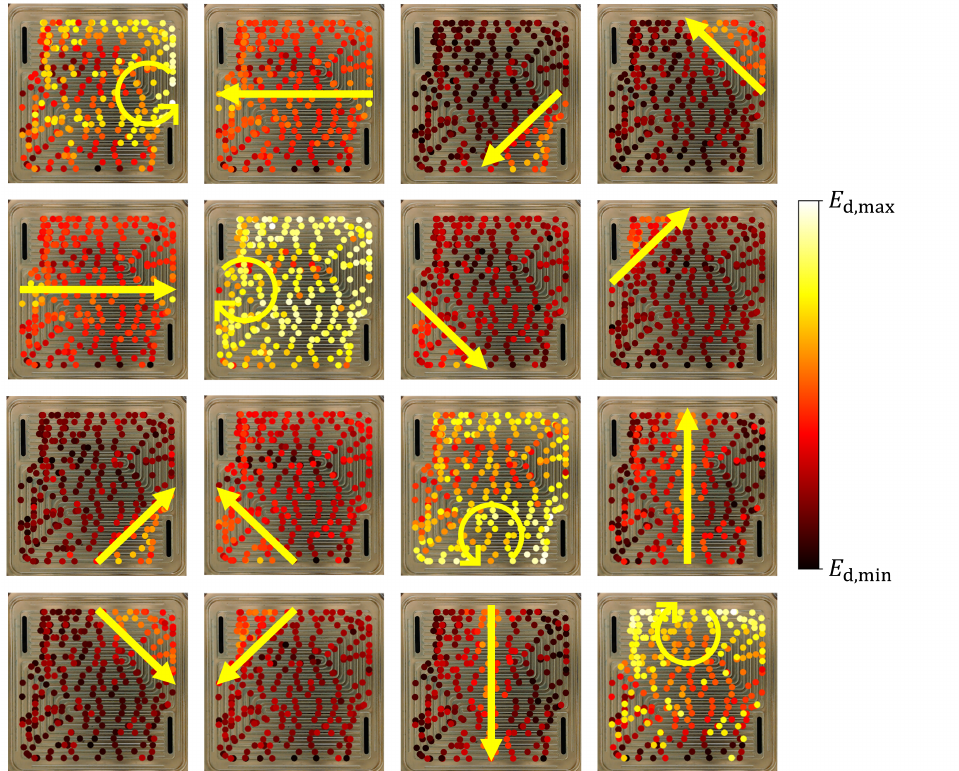
Figure 6. Change in the signal energy of the difference signal E d depending on the position of the drop. The arrows indicate the signal path from the transmitter to the receiver. The colors indicate the value of E d relative to the minimum and maximum values for each signal